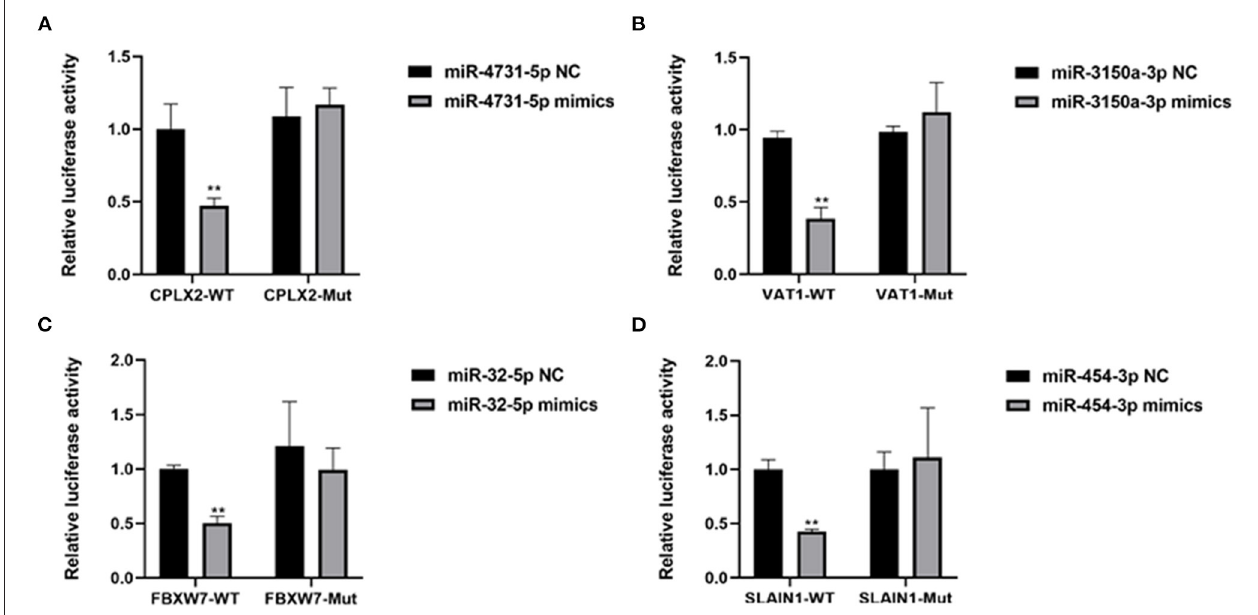
FIGURE 5 | (A–D) The regulation of miR-4731-5p to CPLX2, miR-3150a-3p to VAT1, miR-32-5p to FBXW7, and miR-454-3p to SLAIN1 was detected by dual-luciferase reporter assay. ** P < 0.01, miRNA mimics group vs. NC group.